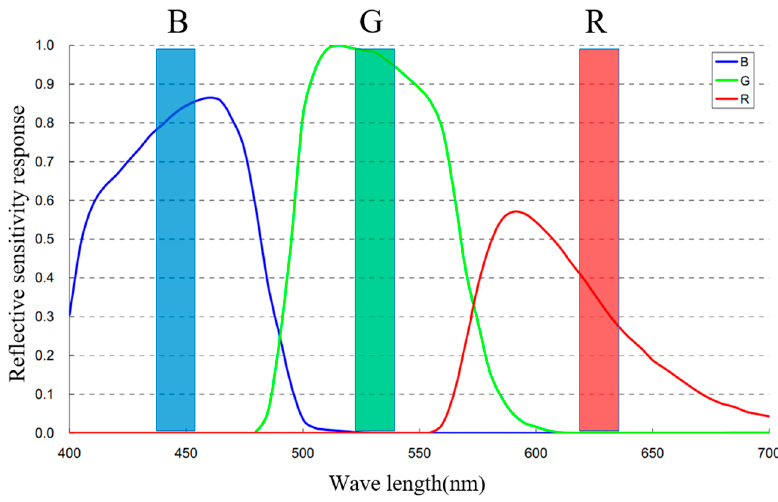
Figure 1. Quantum efficiency of the color camera.